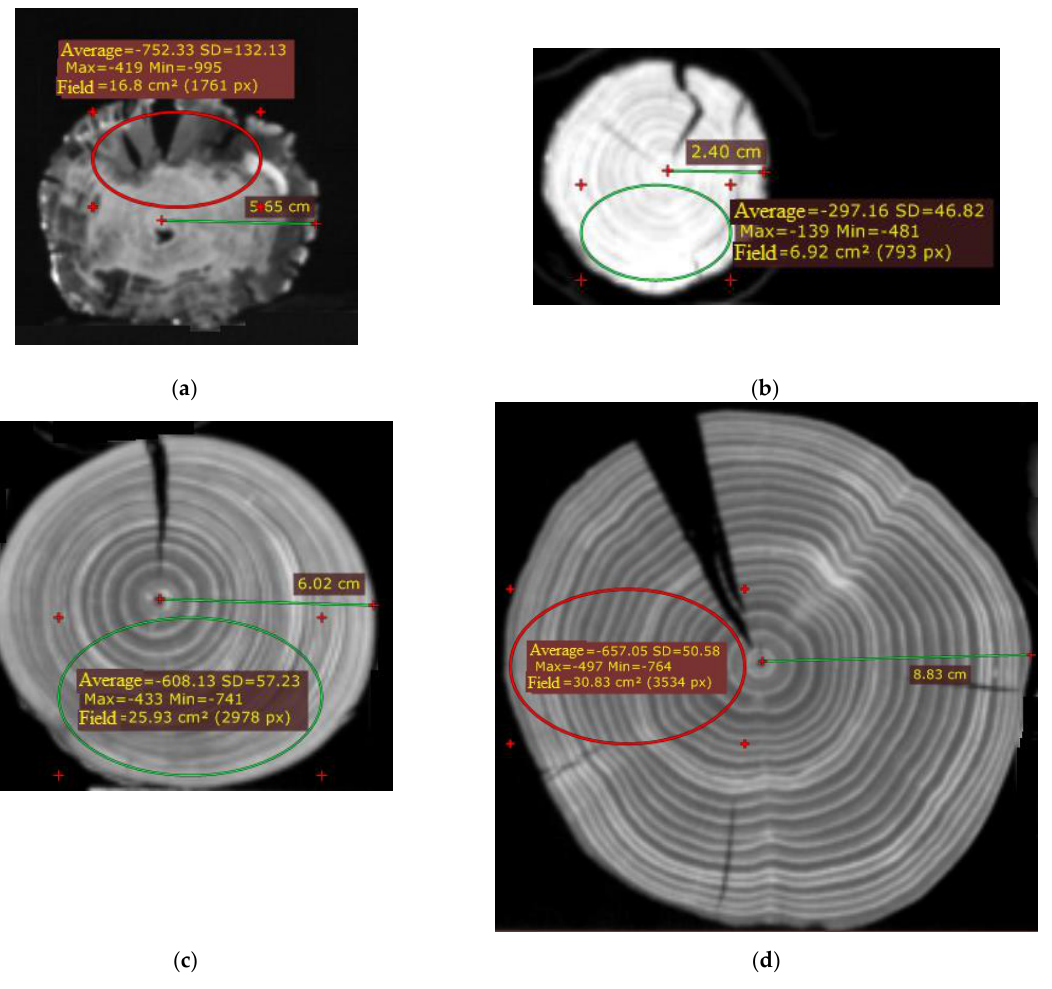
Figure 6. Computed tomographic reconstruction of a cross-sectional image (lighter shade of grey corresponds to higher wood density): ( a ) alder wood sample Ols1–LW, ( b ) oak wood sample Db3–KR2W, ( c ) pine wood sample So2–KR1W, ( d ) spruce wood sample Sw2–OGW.